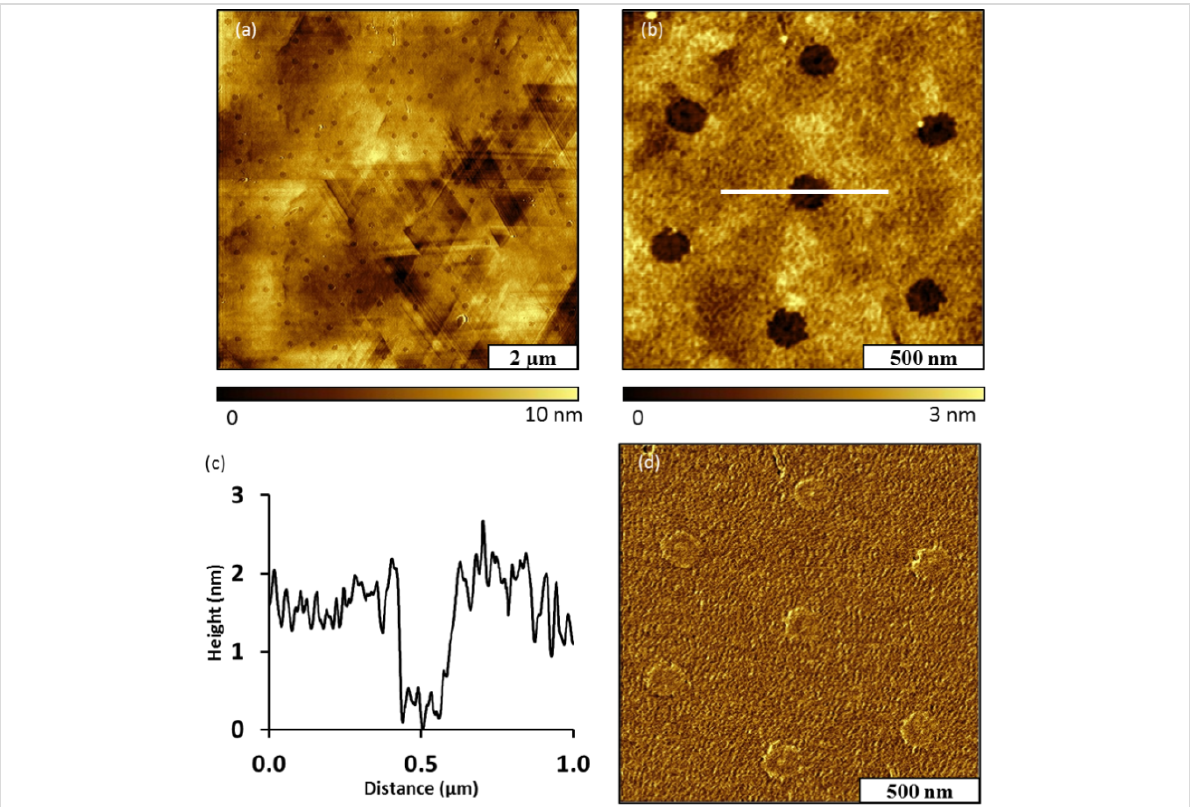
Figure 1: Nanopores within a film of Au–Me on Au(111) produced using immersion particle lithography and the radical precursor Phth–Me. (a) Topog- raphy image acquired in air; (b) zoom-in view of hexagonally packed nanopores; (c) cursor profile across a single nanopore in (b); (d) corresponding phase image of